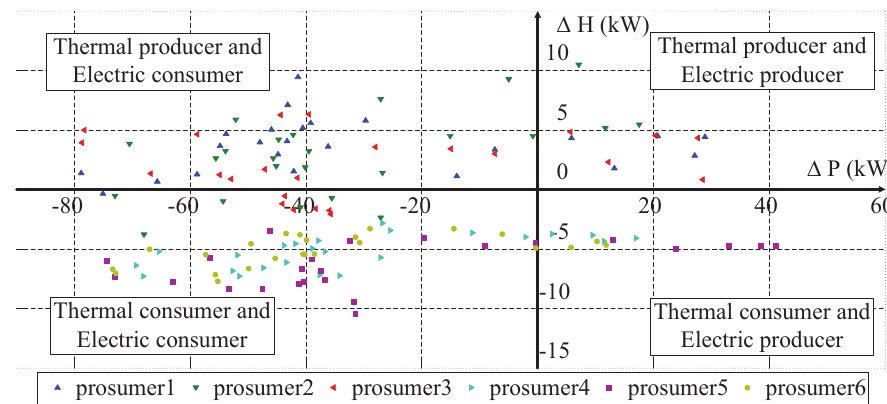
Figure 8. Roles of prosumer during the